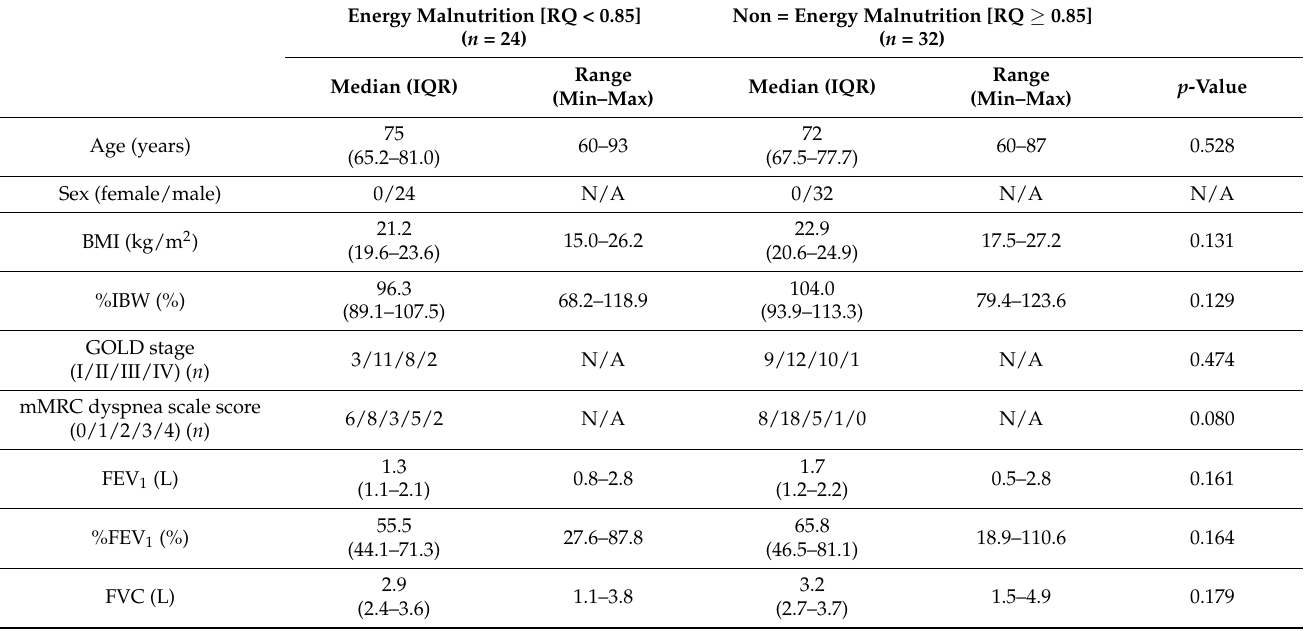
Table 2. Comparison of baseline, energy metabolism, biochemical tests, body composition, physical function, and muscle mass in subjects with and without energy malnutrition (with RQ < 0.85 and RQ ≥